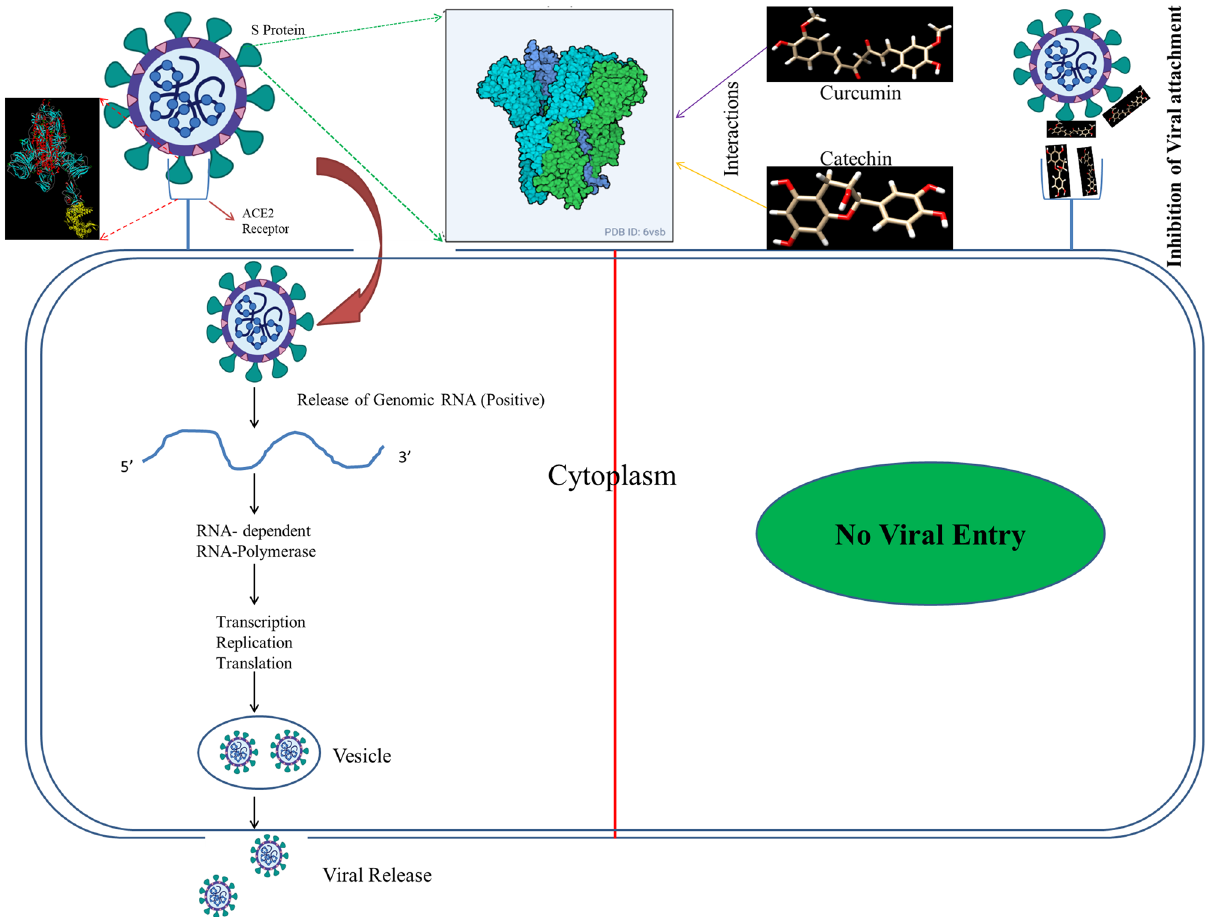
Figure 1. Pictorial depiction of the binding of viral S Protein with the ACE2 cellular receptor. The presence of catechin and curcumin inhibits S Protein and ACE2 interaction and eventually prevents viral